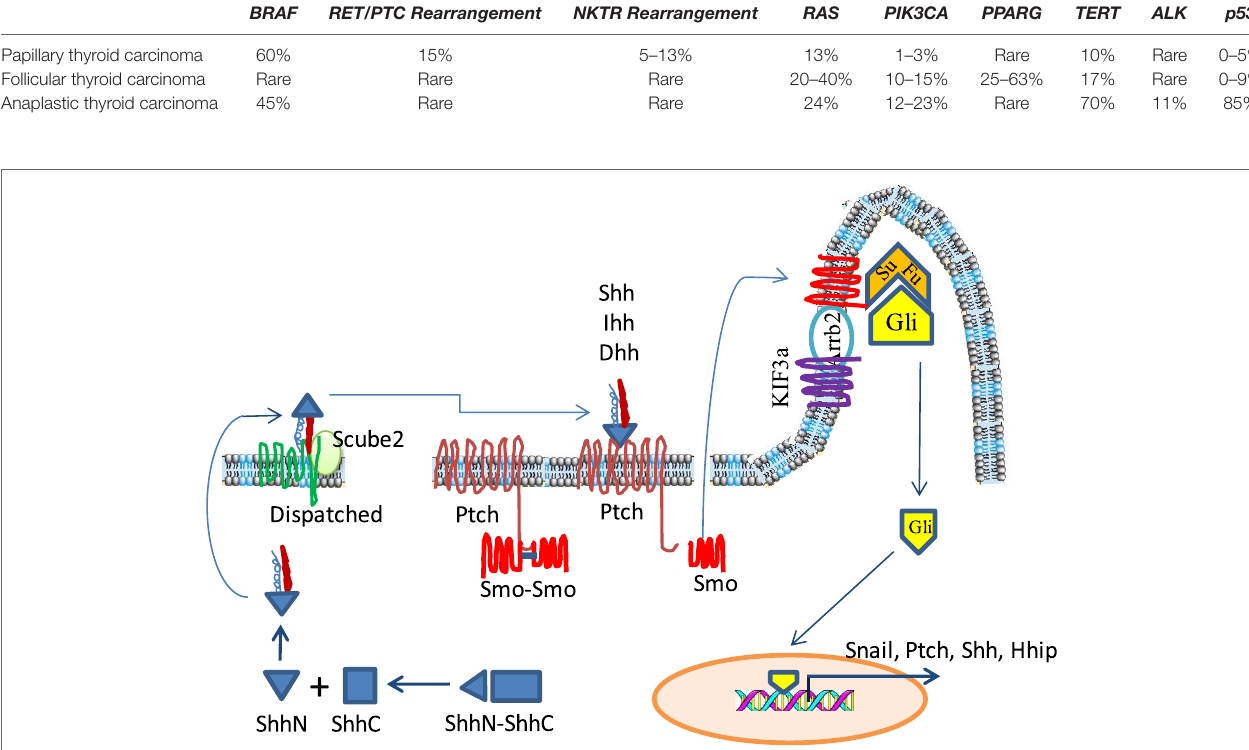
TABLe 1 | Major genetic alterations in thyroid follicular cell carcinomas. BRAF RET/PTC